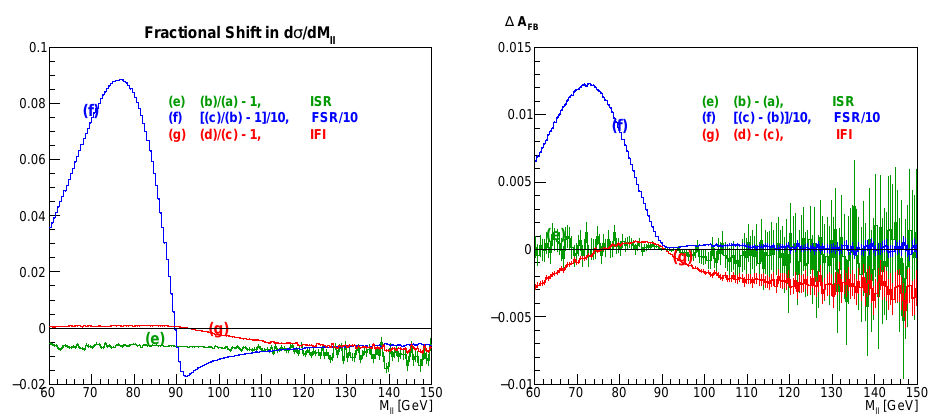
Figure 1: This figure shows shows the effects of adding ISR (green), FSR (blue), and IFI (red) incrementally, with the FSR contribution divided by 10 so that it fits on the same scale. The figure on the left shows the fractional changes to the M for each, and the figure on the right shows the absolute changes in A